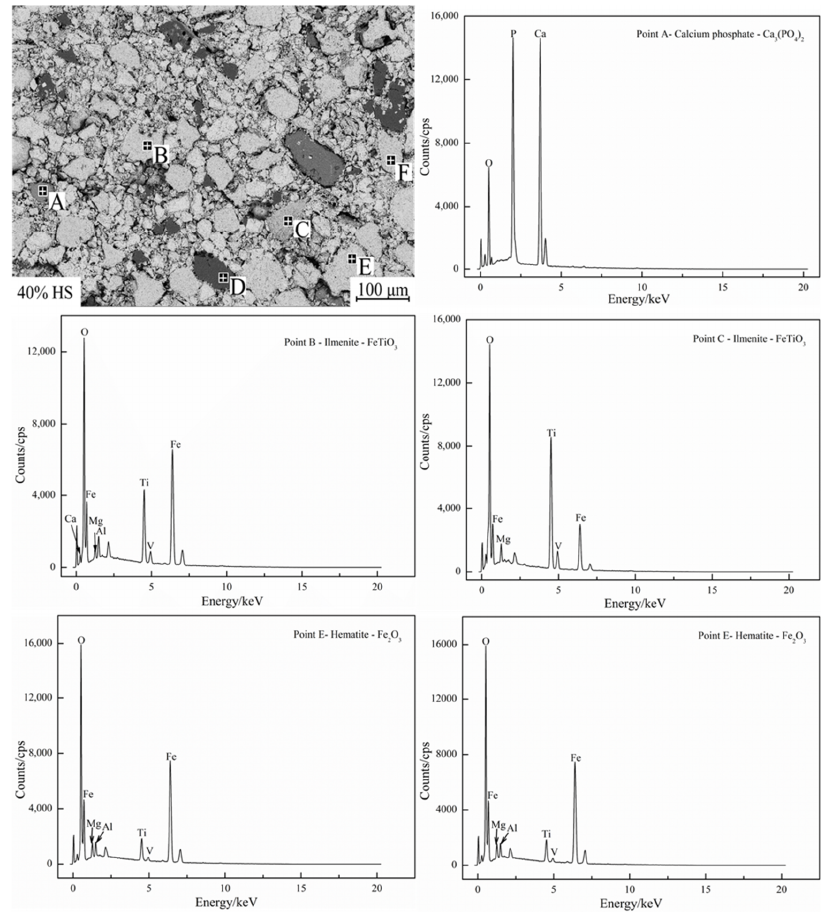
Figure 8. EDS graph of oxidized pellets with 40% sea sand ore. Table 6. Compositions of main phases in oxidized pellets with 40% sea sand ore detected by EDS (wt. %).